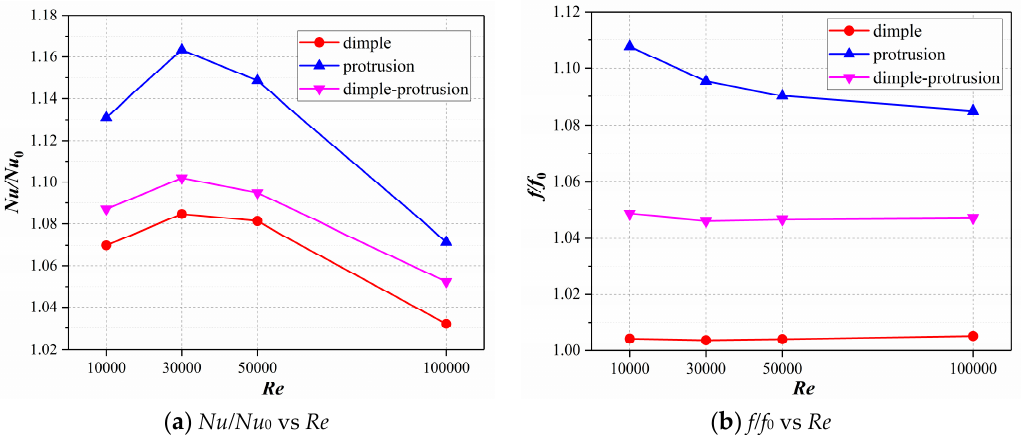
Figure 12. Variations of relative Nusselt number and relative friction with Re for different dimple/protrusion arrangements.